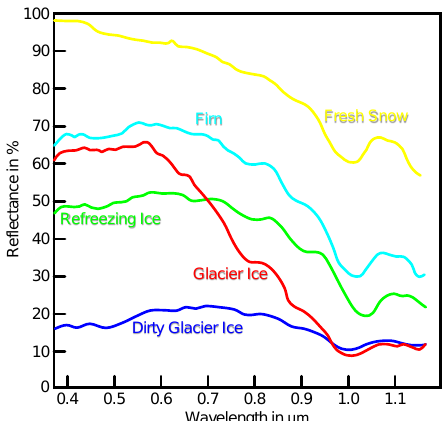
Figure 3. Spectral signatures for snow and ice classes [8], cf.